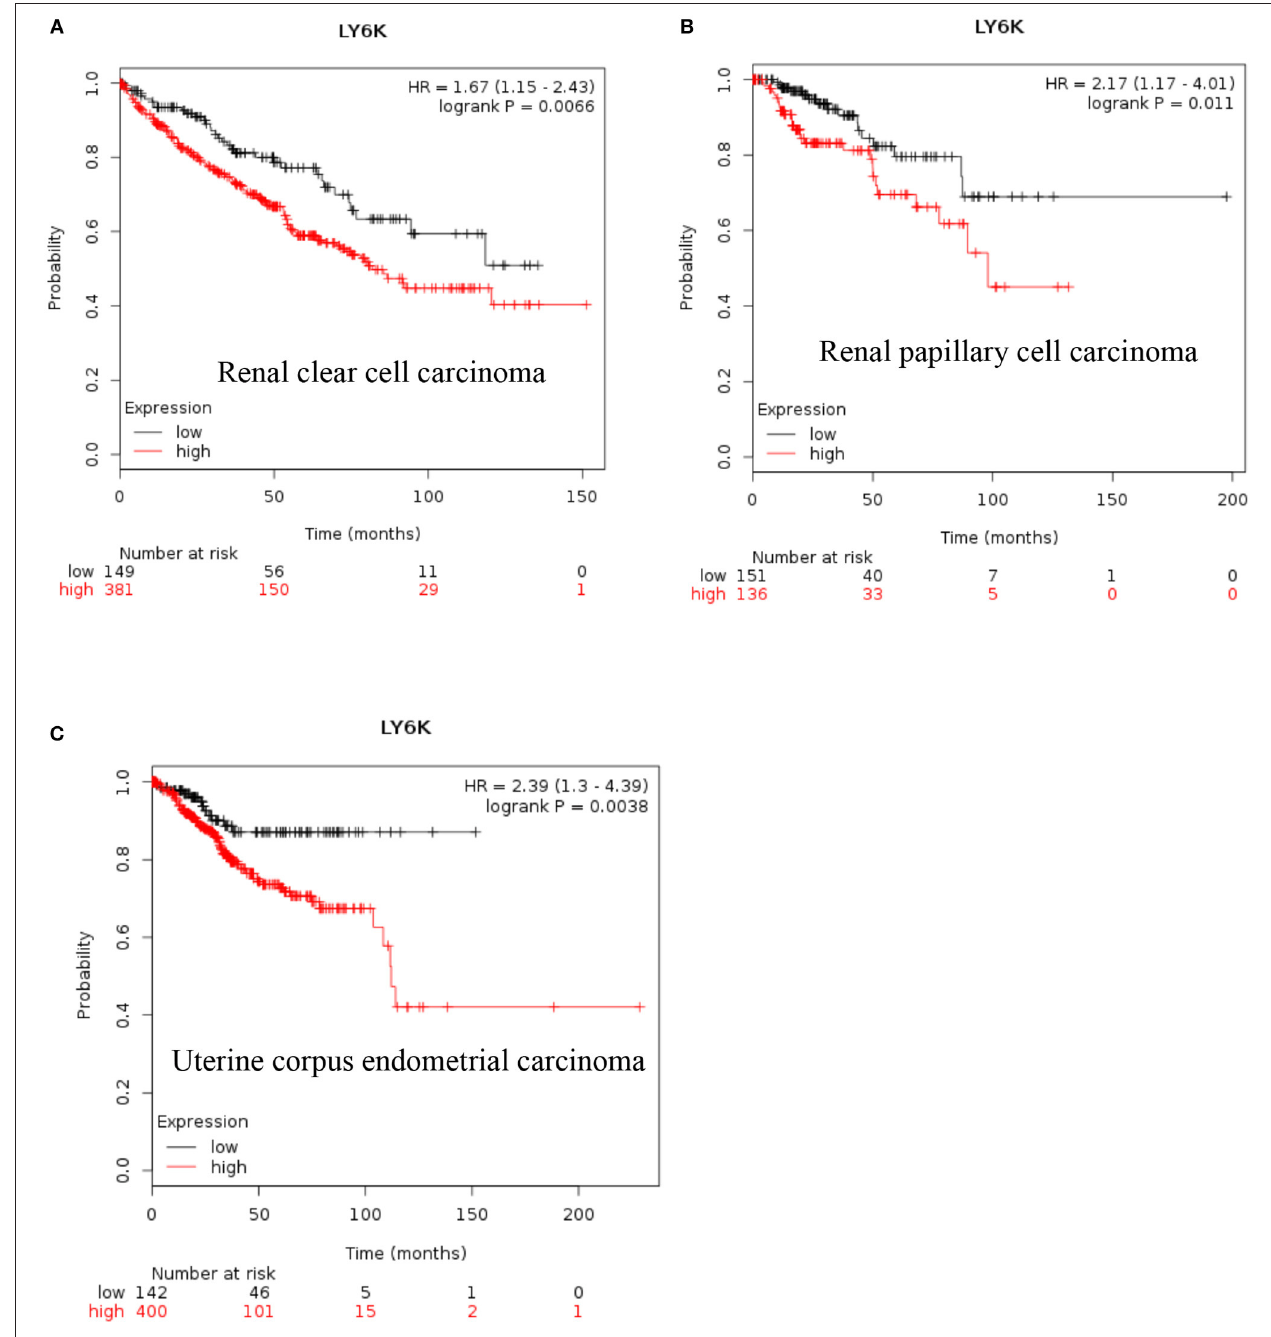
FIGURE 4 | Increased LY6K mRNA expression in cancer and patient survival. High Ly6K RNA expression leads to poor survival in (A) renal clear cell carcinoma, (B) renal papillary cell carcinoma and, (C) pancreatic ductal adenocarcinoma (38).